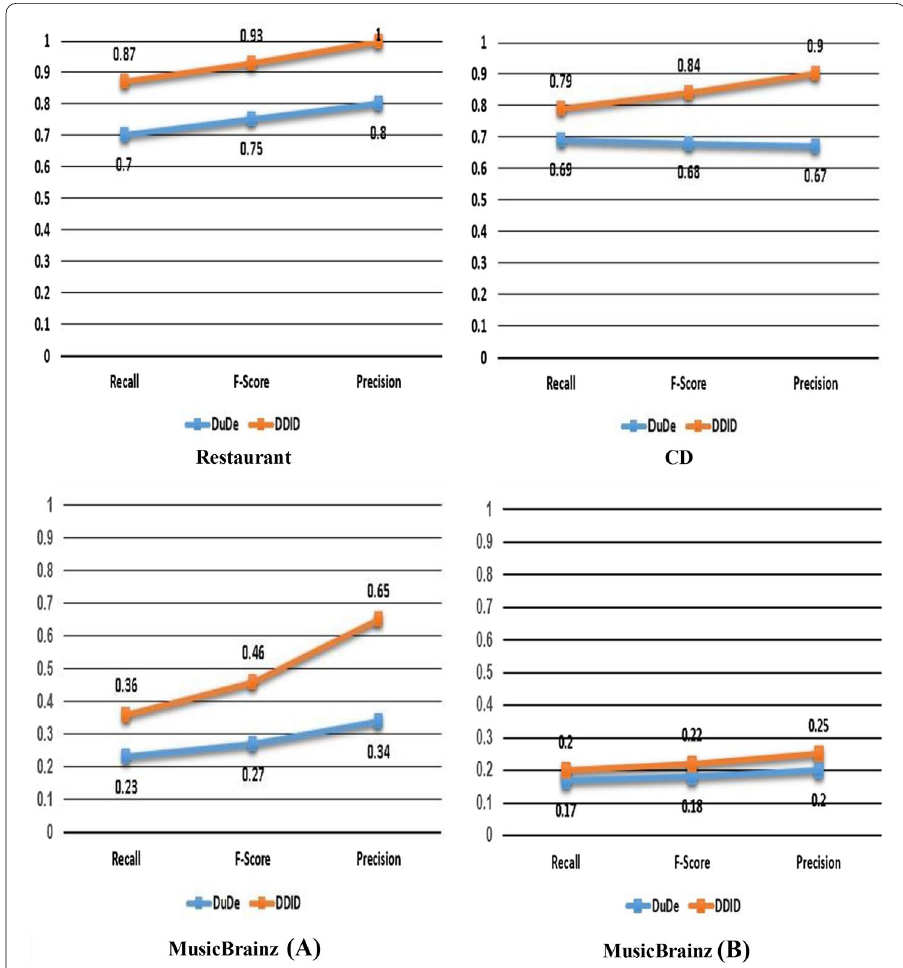
Fig. 4 Accuracy comparison of performance between DDID and DuDe